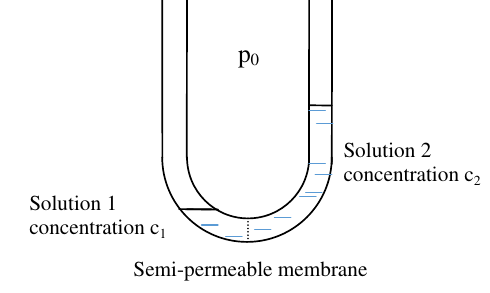
FIG. 1. A typical situation of osmotic equilibrium ( c 2 > c 1